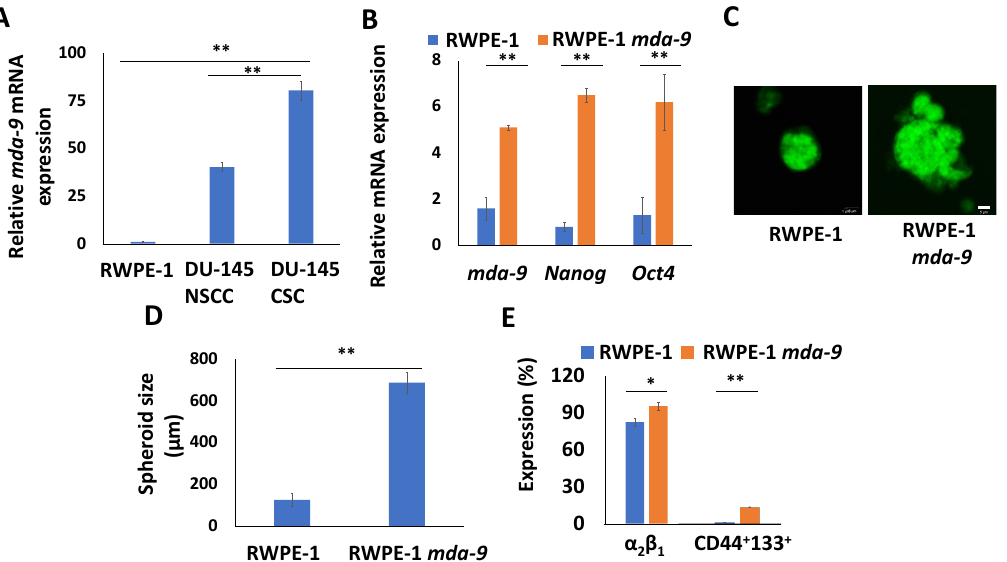
Figure 1. mda-9 Expression correlates with stemness markers. ( A ) Expression of mda-9 in normal prostate and prostate cancer stem cells. ( B ) Expression of Nanog, and Oct4 in mda-9 overexpressing normal prostate stem cells. ( C ) Confocal image showing the size of RWPE-1 cells in parental and mda-9 overexpressing prostaspheres. ( D ) Graphical depiction of the spheroid size in RWPE-1 prostaspheres in parental and mda-9 overexpressing cells. ( E ) E ff ect of mda-9 overexpression on normal prostate stem cell populations. The scale bars represent 20 µ m. * p < 0.05, ** p < 0.01, using the Student’s t -test and